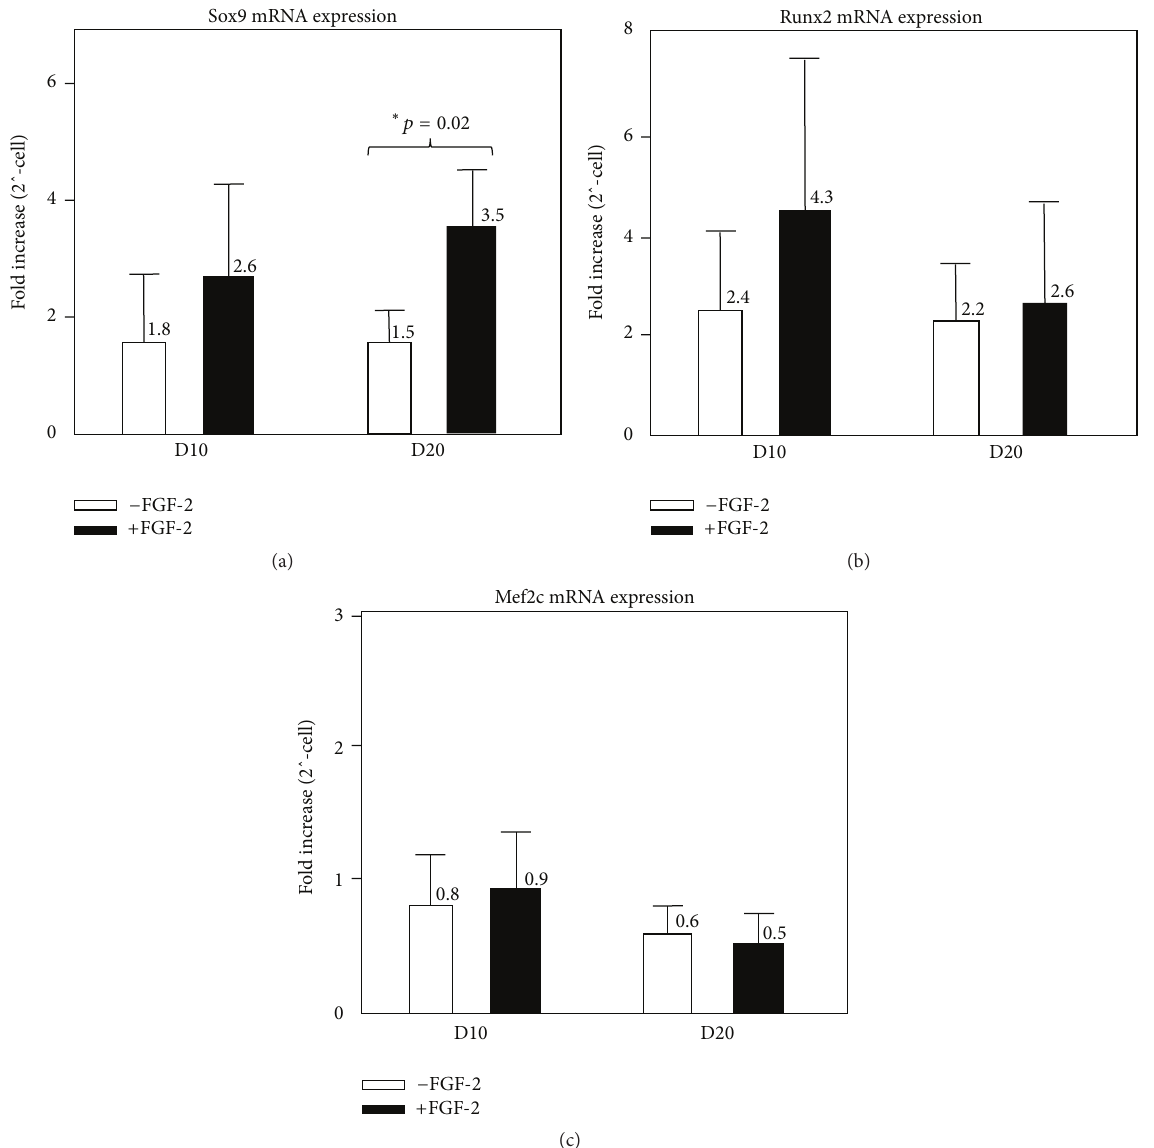
Figure 4: Sox9 (a), Runx2 (b), and Mef2c (c) mRNA expression (fold increase) on days 10 and 20 of chondrogenic culture with (white) or without (black) FGF-2 supplementation ( 𝑛 = 3 ; 3;